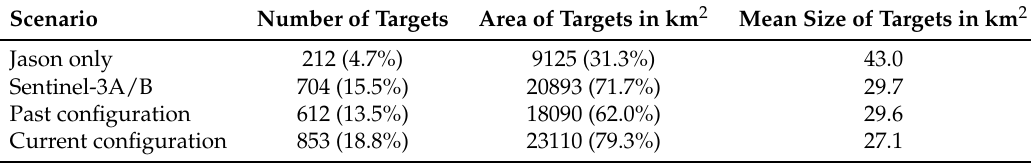
Table 2. Number and area of lakes/reservoirs larger than 0.1 km 2 covered by different altimetry constellations.